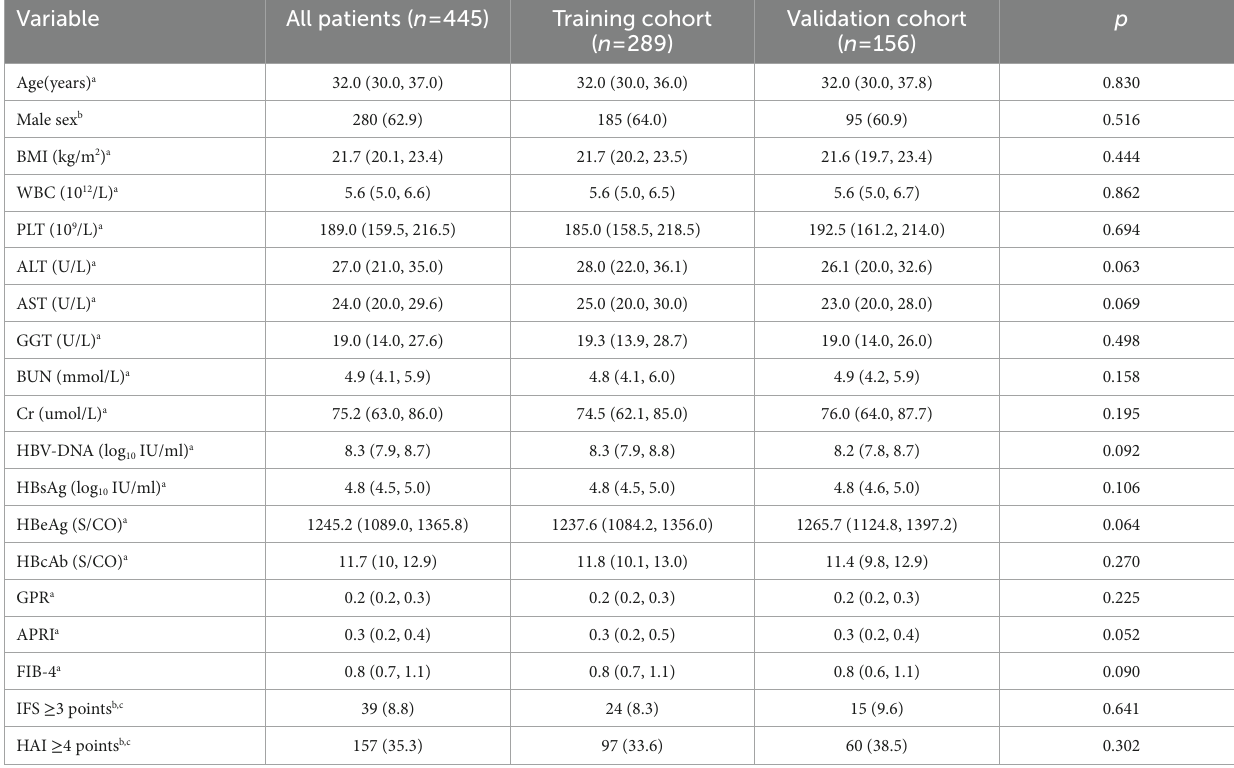
TABLE 1 Baseline characteristics of patients in the training and validation cohorts.